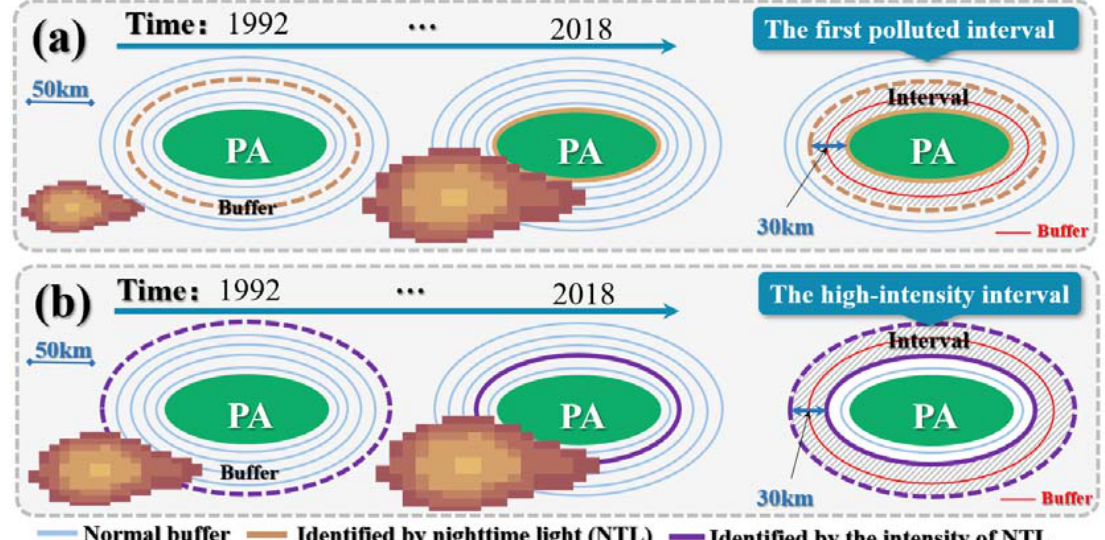
Figure 3. Conceptual illustration of buffer intervals around PA revealed by the first polluted buffer ( a ) and the high-intensity buffer ( b ). Note: yellow and purple were used to indicate different pollution intervals (i.e., the first pollution and high-intensity interval).